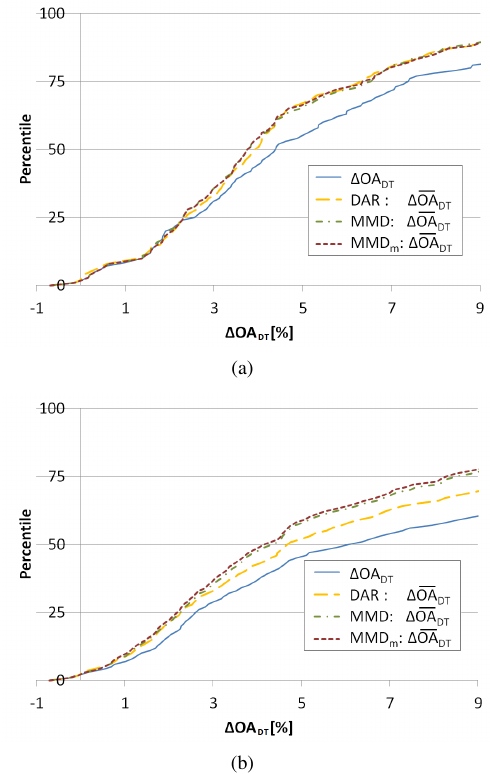
Figure 6: Percentile plots of ∆OA DT after the negative transfer prediction using three metrics for Vaihingen (a) and Potsdam (b) and of the results without that prediction ( ∆OA DA ) (the higher the